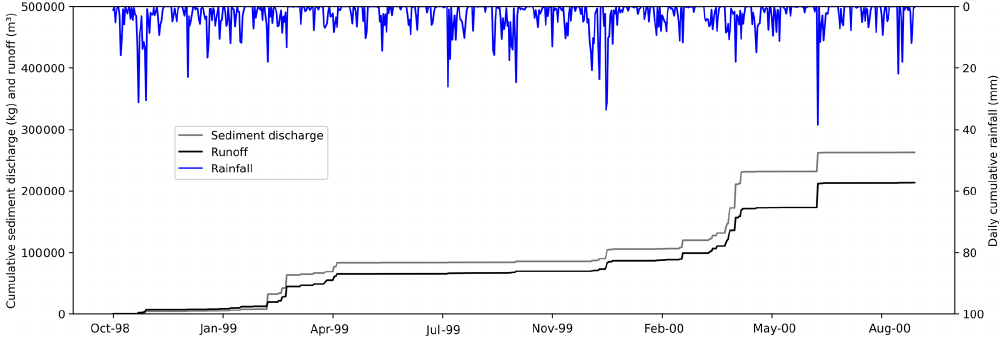
Figure 3. Cumulative sediment discharge (kg) and runoff (m 3 ) simulated by the WaterSed model, extracted and summed over all positively connected sinkholes from October 1998 to September 2000.